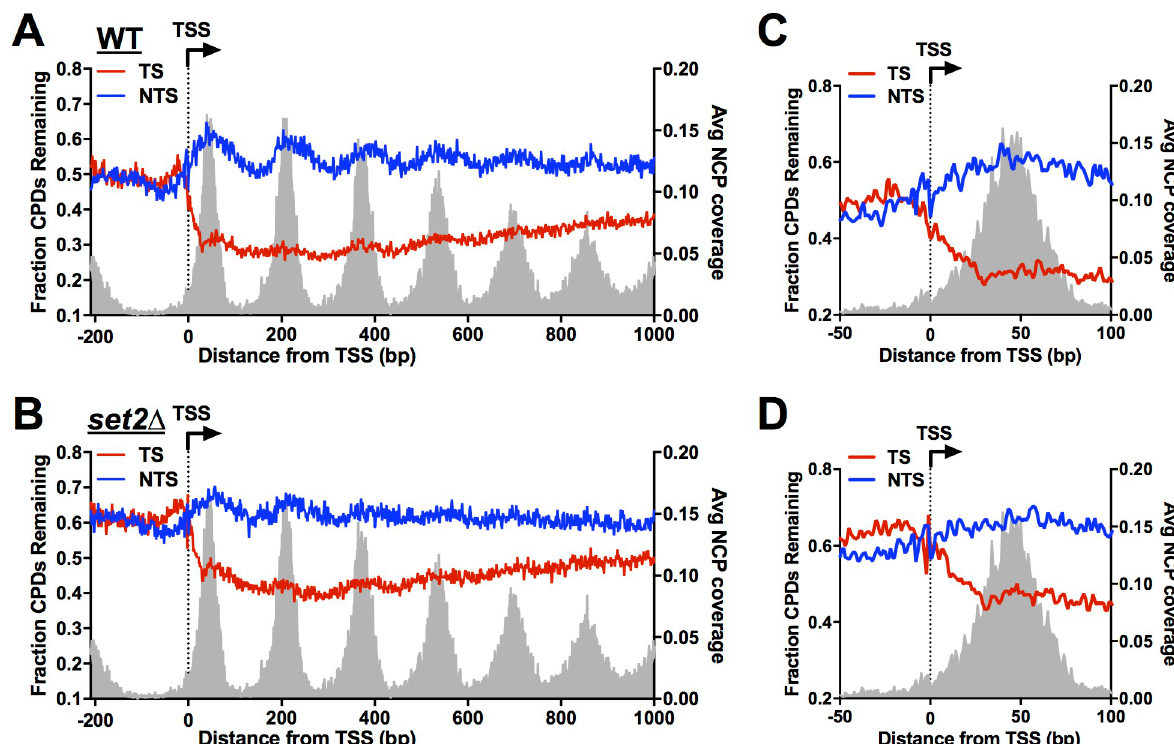
Fig 3. High-resolution CPD-seq analysis of repair around the transcription start site in set2 Δ mutant cells. ( A ) Single nucleotide resolution analysis of CPD-seq data on both transcribed strand (TS) and nontranscribed strand (NTS) of ~5200 yeast genes around the transcription start site (TSS). The plots depict fraction of unrepaired CPDs following 2hr repair relative to no repair (0hr) for both TS and NTS in WT cells. The data is plotted for each nucleotide positioning spanning -200 bp upstream and +1000 bp downstream of the TSS. CPD-seq data was scaled using the overall repair data for the 2hr time point from alkaline gel analysis (Fig 1G). The positions of nucleosome dyads [77] are shown for reference. ( B ) Same as panel A , except the data is from set2 Δ cells. (C,D) Close-up of CPD-seq data near the TSS within the region of +1 nucleosome in the WT ( C ) and set2 Δ ( D ) cells. Nucleosome positioning data for the +1 nucleosome is shown for reference.